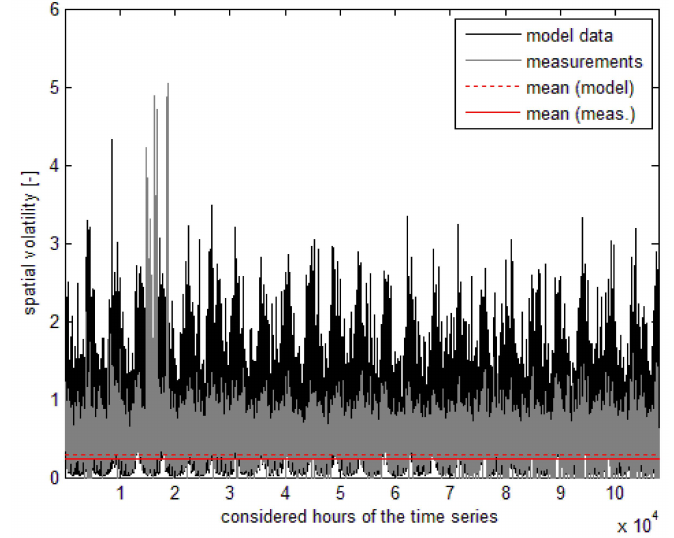
Figure 7. Spatial volatility of the measured and modeled data respectively.